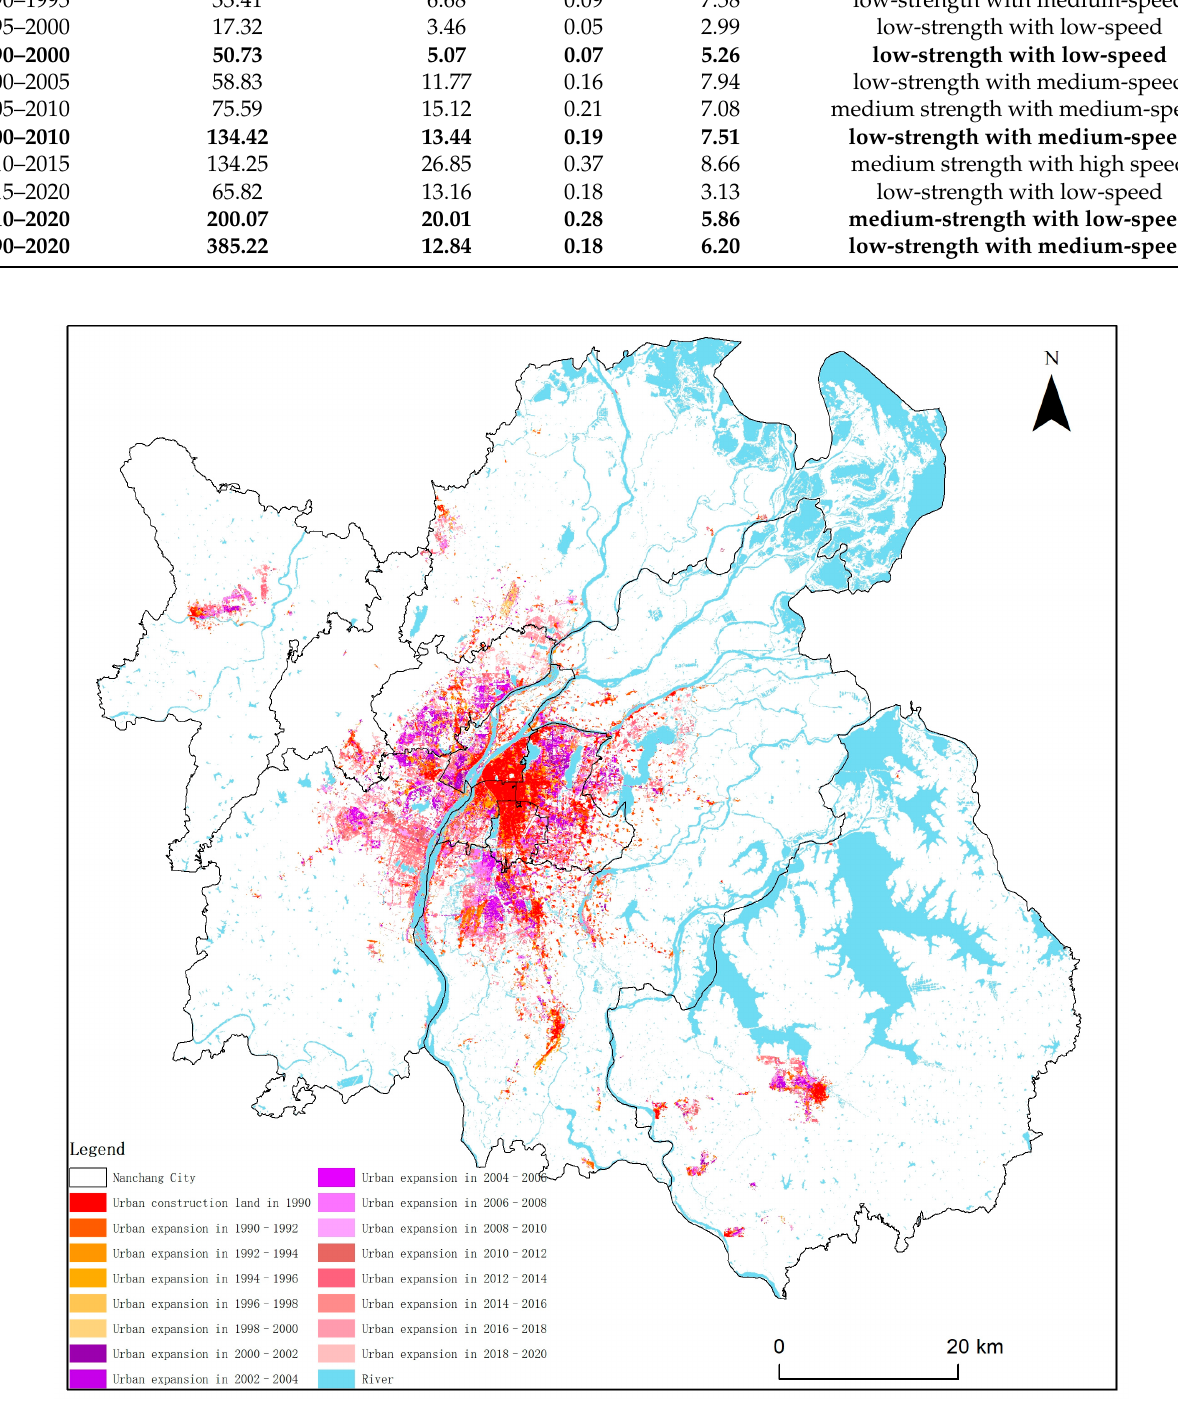
Figure 3. Quantity Change of urban land in Nanchang city from 1990 to 2020. Table 2. Statistical table of urban construction land area change in Nanchang city from 1990 to 2020.